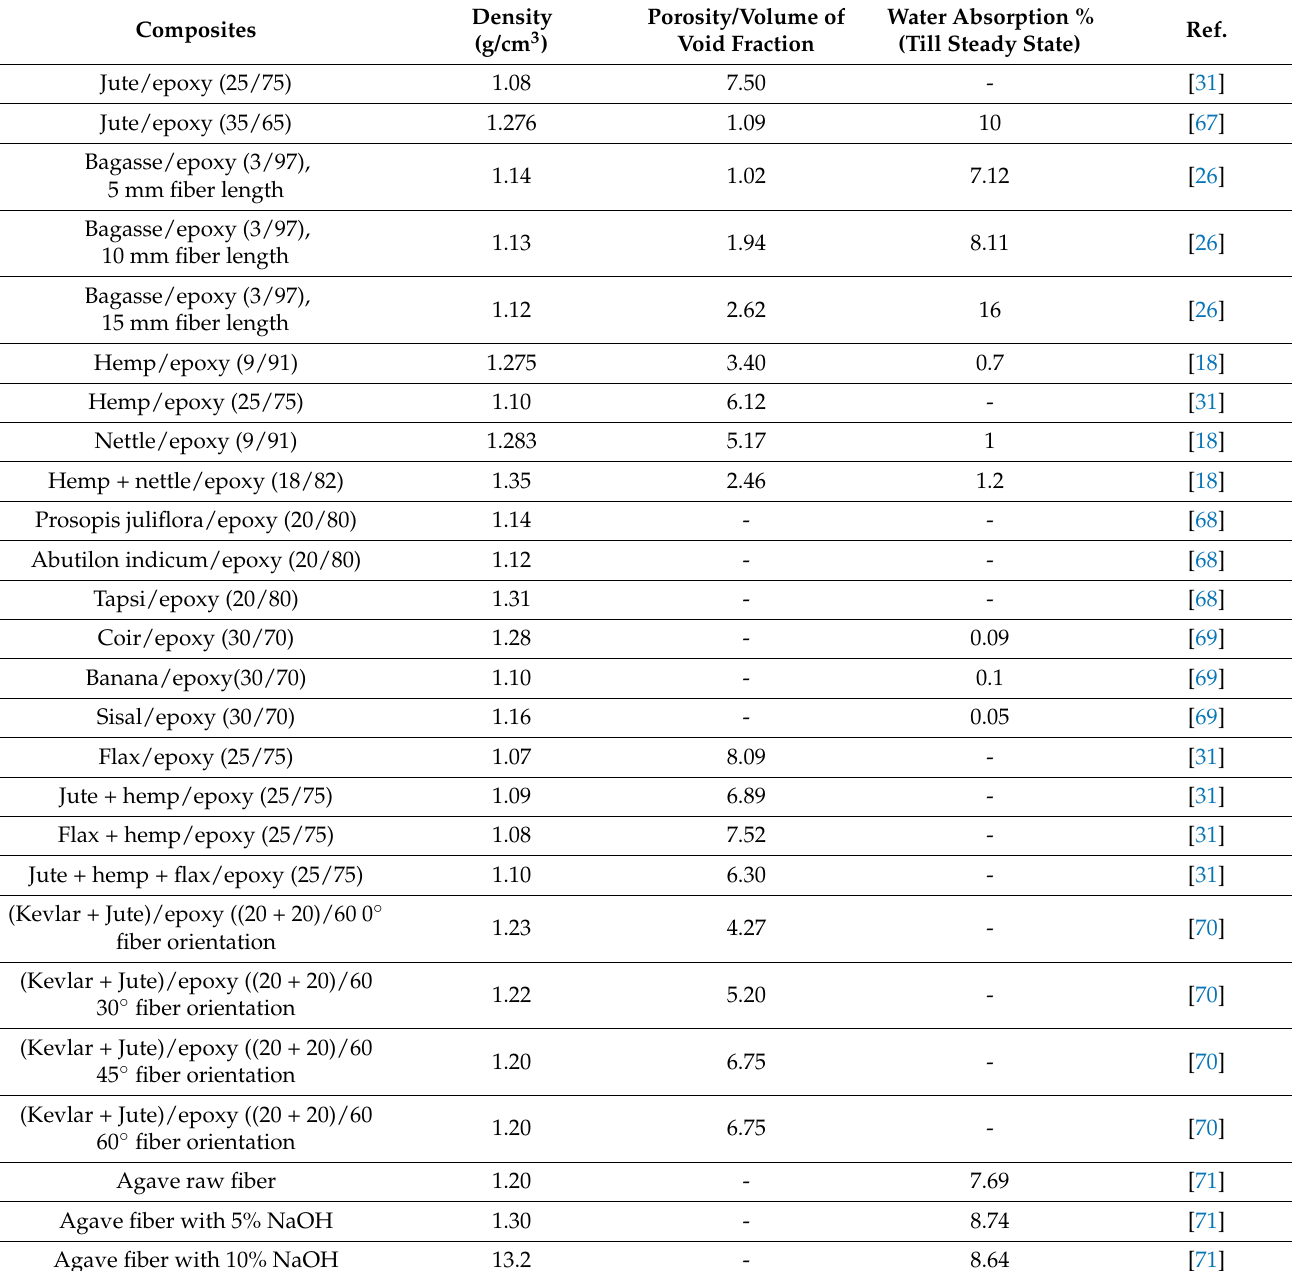
Table 3. Physical properties of natural fiber-reinforced epoxy